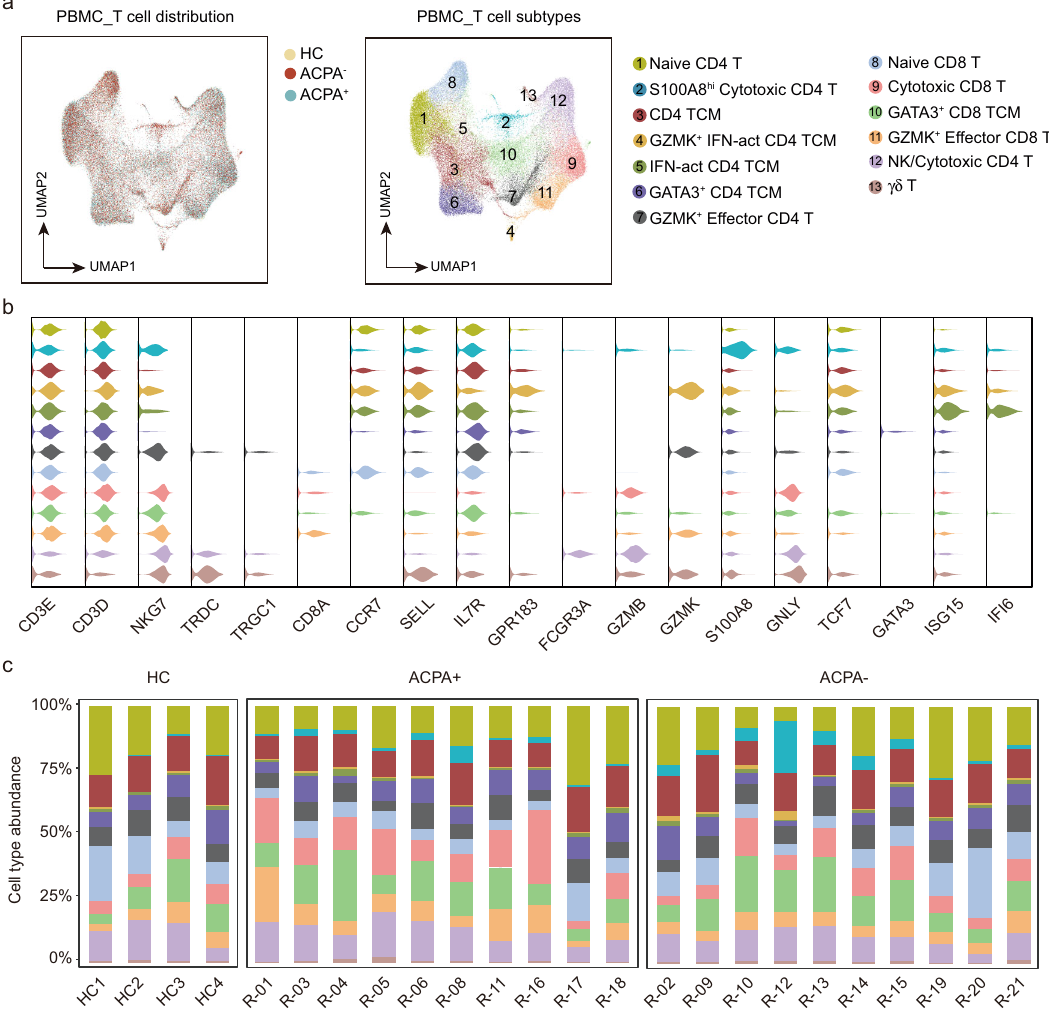
Fig. 7 Heterogeneous subpopulations of T and NK cell subsets in the blood of patients with RA. a UMAP visualization of T/NK cells from PBMC, with 13 cell subtypes identi fi ed across 70,650 cells. Cells are marked by ACPA type(left) and cell subtypes (right). b Violin plots showing marker genes across PBMC T/NK cell subtypes in a. The y axis represents log-scaled normalized counts. c Bar plots showing the relative percentage of T/NK cell subtypes in PBMC for each